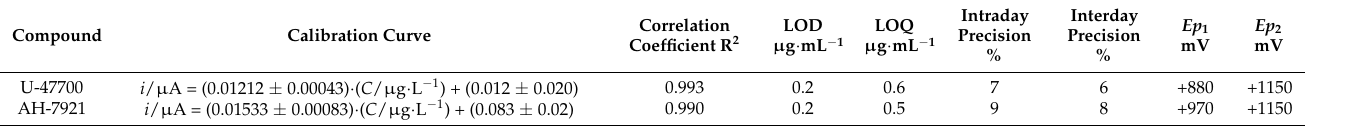
Figure 9. DPV of AH-7921 in ethanol/0.1 M lithium perchlorate and 0.10 M 2,6-lutidine; concentra- tion range: from 5 µg·mL − 1 to 150 µg·mL − 1 . Potentials are referred to Ag/AgCl, 3 M NaCl. Scan speed: 50 mV·s − 1 . Working electrode: glassy carbon, 2 mm diameter.